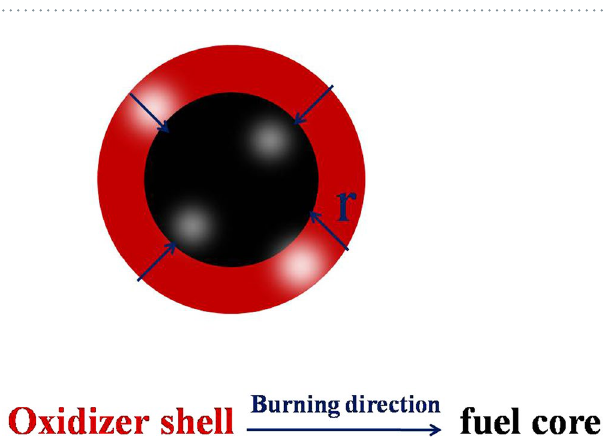
Figure 7. Pressure cell test on A: MM Kp and Al/CuO B: Kp@Al/CuO Nps.